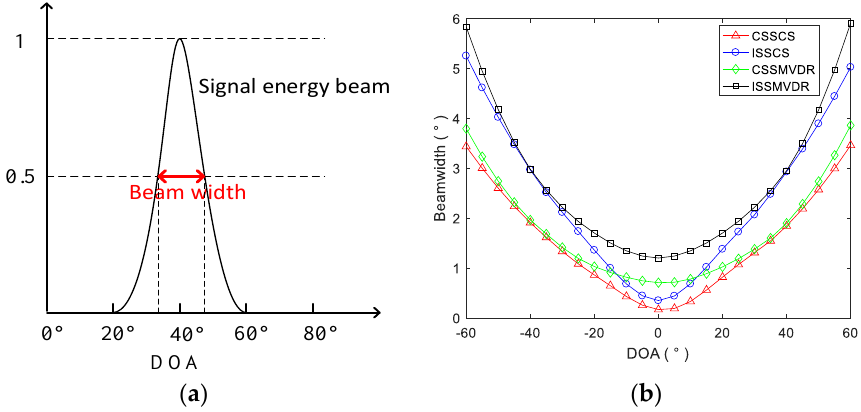
Figure 5. The definition of beam width and the four methods’ beam widths for DOA estimation. ( a )